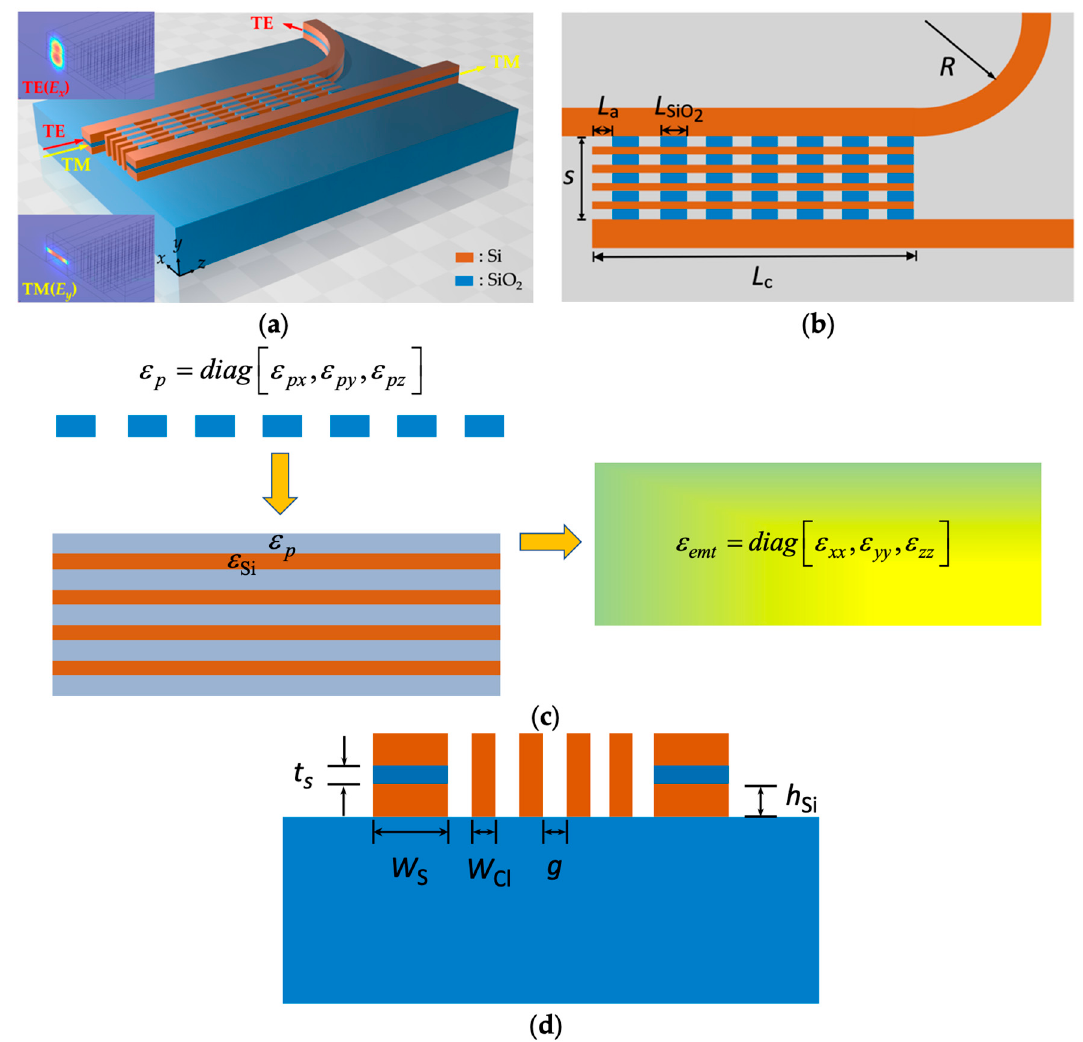
Figure 1. ( a ) 3D diagram with TE ( E x ) and TM ( E y ) mode profiles in the incident plane; ( b ) top view; ( c ) schematic of calculating the resultant effective permittivity ε emt of 2D SWGMs, which is obtained by sequentially estimating the 1D SWGMs in the z ( ε p ) and x directions ( ε emt ) on the basis of EMT between slot waveguides; ( d ) cross-section in xy plane of the present PBS.